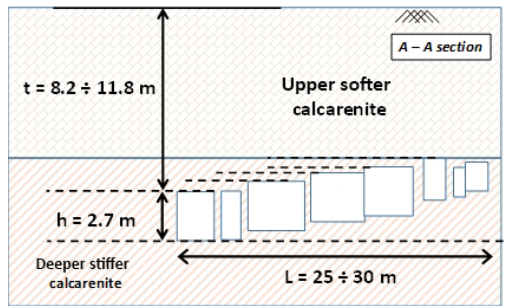
Figure 11. Stratigraphy of Marsala underground quarry traced along the A-A